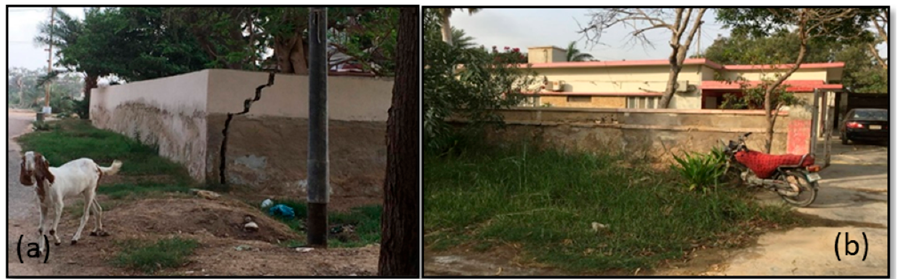
Figure 10. Signs of ground displacements in the study area. ( a ) Cracks in the building walls due to differential ground displacement; ( b ) elevation of a residential house in the University of Karachi’s Professors colony has dropped to ~2 m below its base-level due to soil liquefaction caused by seawater intrusion. During the field visit, signs of soil salinity were observed in different parts of the University of Karachi.